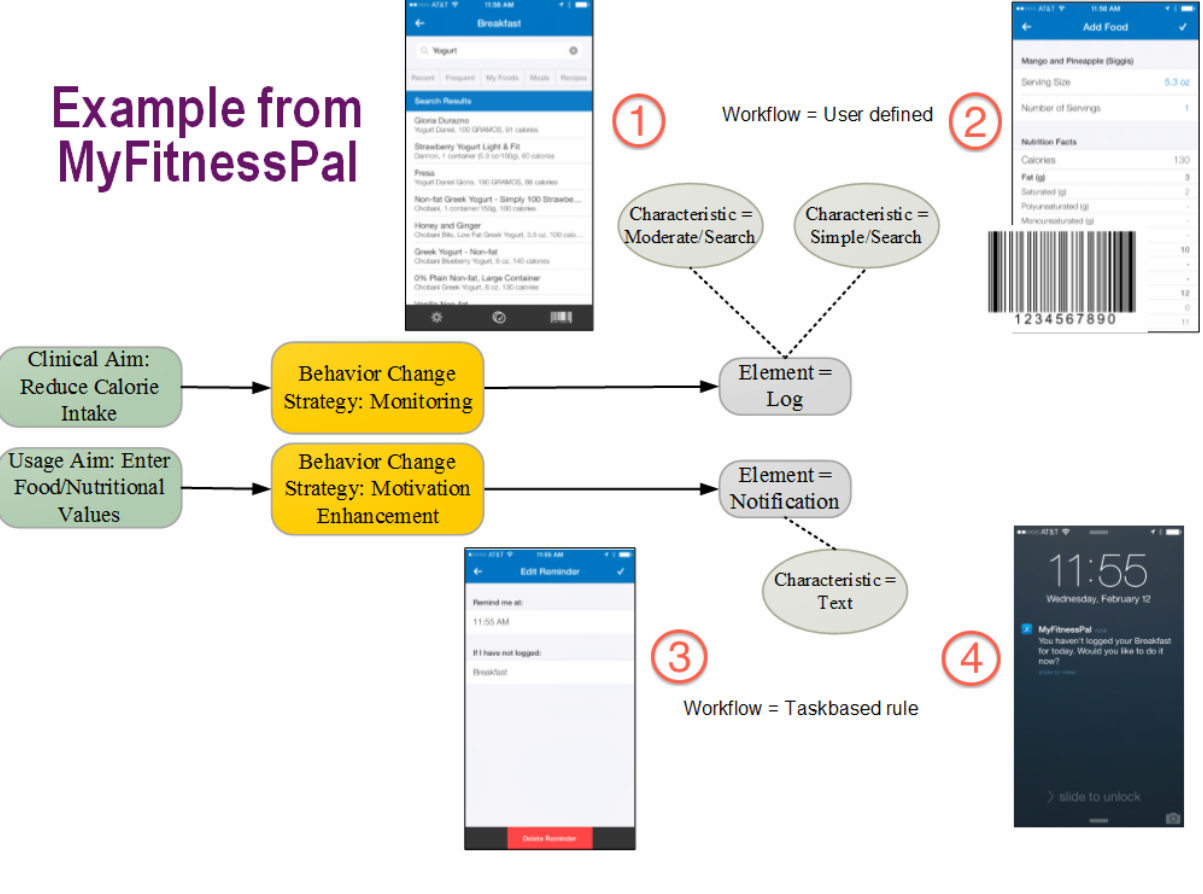
Figure 2. BIT model example using MyFitnessPal calorie intake monitoring